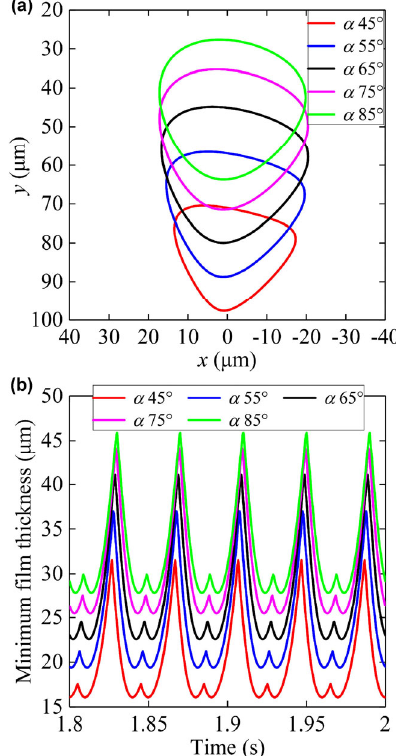
Fig. 15 (a) Journal center orbits and (b) dynamic minimum film thicknesses of a TPJB with static loads for different pad arc angles.